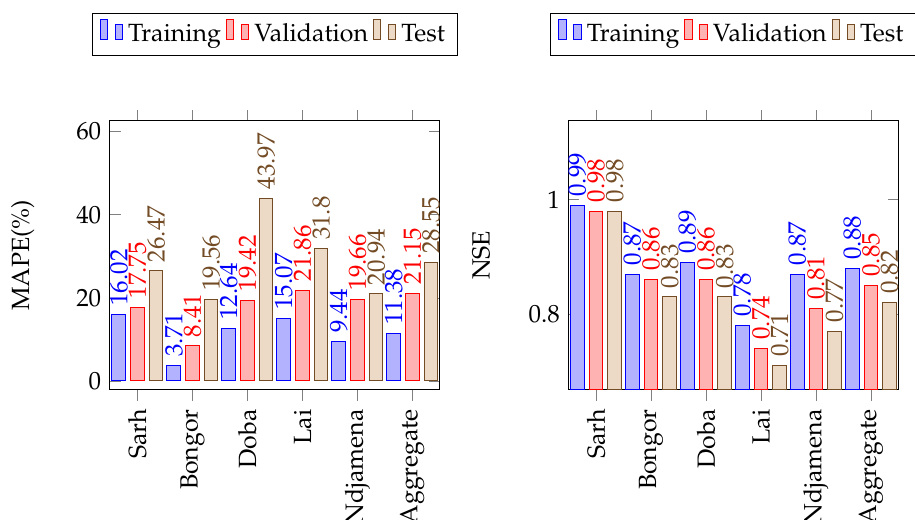
Figure 9. The LSTM model performance on the training, validation and test sets of precipitation in the Lake Chad Basin. The number of simulations run were 20 in all cases.